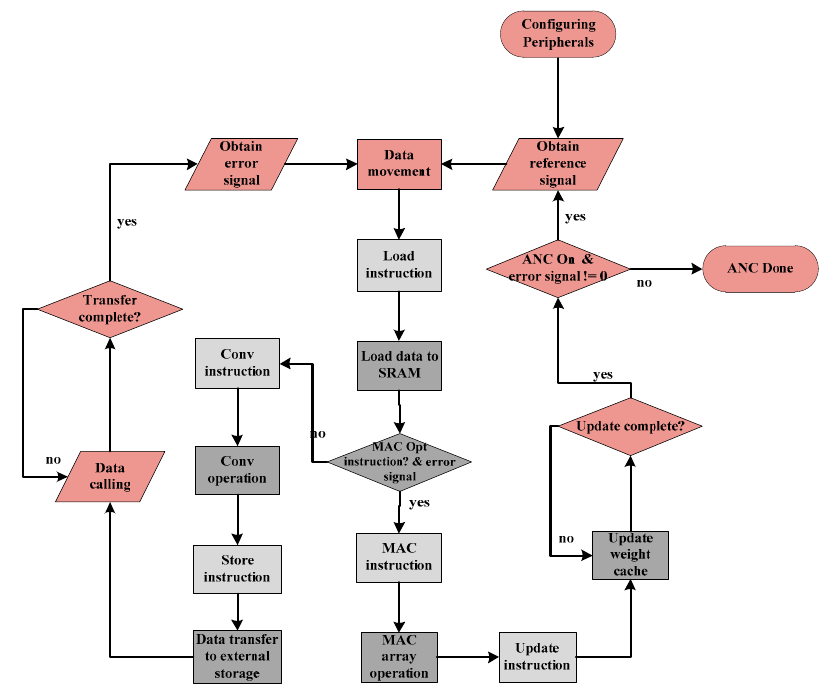
Figure 3. Flow chart of software and hardware co-design.